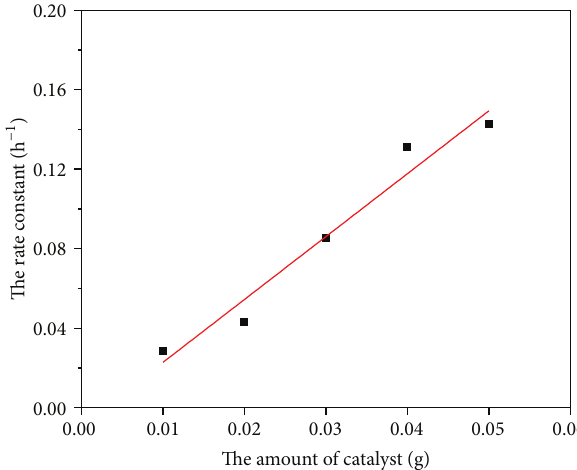
Figure10:Therelationshipofreactionrateconstantandtheamount of